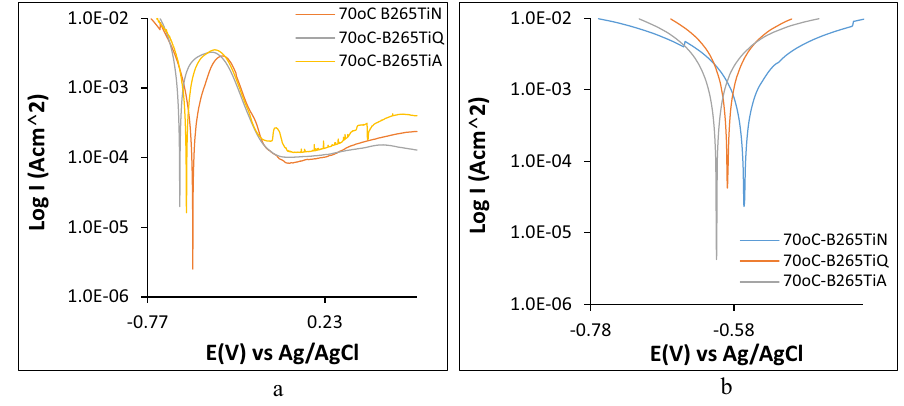
Figure 2: Potentiodynamic plots of B265TiN, B265TiQ, and B265TiA corrosion in ( a ) 2 M H 2 SO 4 + 10% NaCl at 70°C and ( b ) 6 M H 2 SO 4 + 10% NaCl at 70°C.